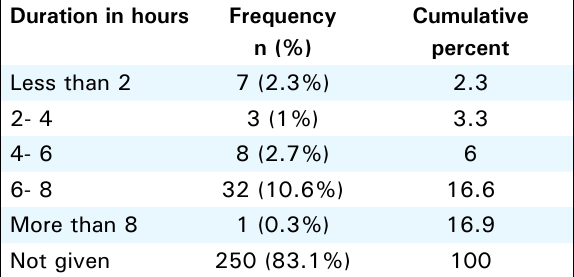
Table 3. Time after which additional drug was used